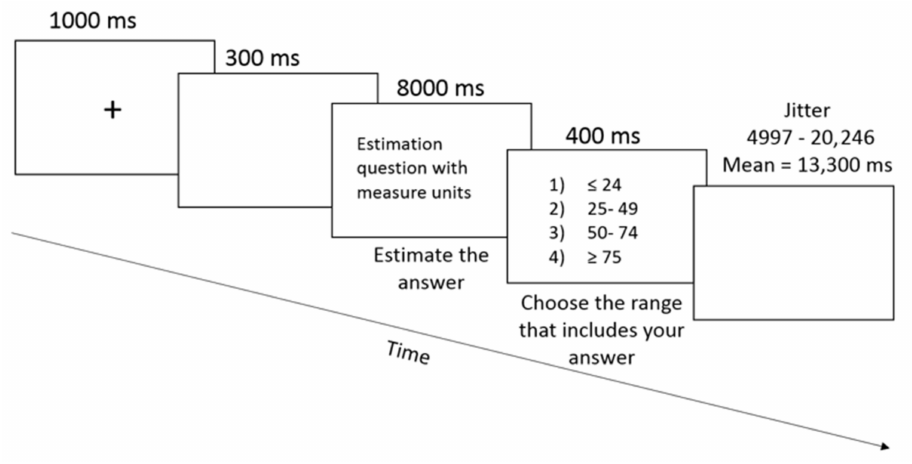
Figure 1. A trial in the cognitive estimation